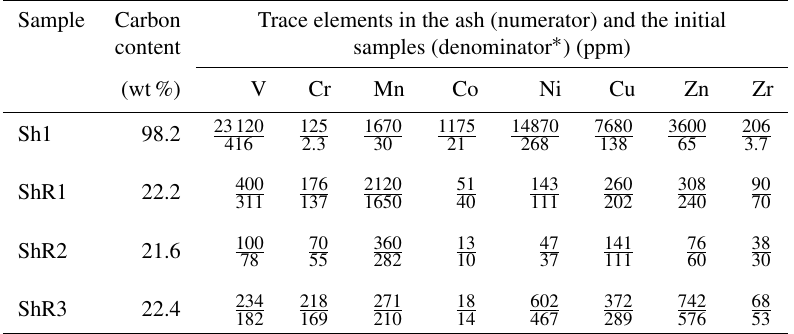
Table 1. The content of some trace elements in the ash of shungite (Sh1) and shungite rock (ShR1, ShR2, ShR3) samples, determined by mass spectrometric analysis with inductively coupled plasma (relative standard deviation values are lower than 7%).